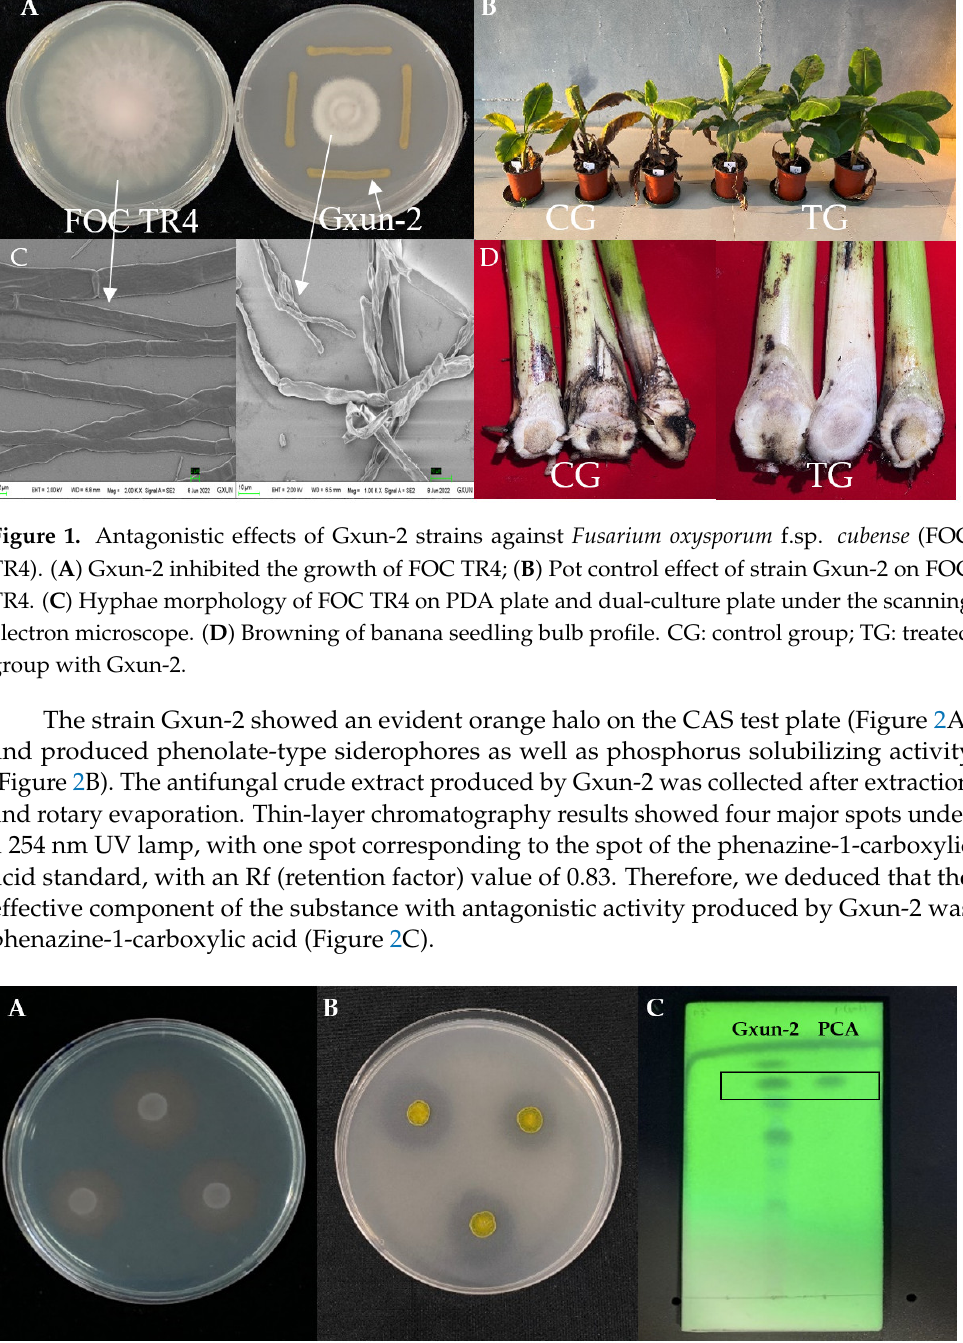
Figure 2. Plant growth-promoting and disease-prevention traits of the strain Gxun-2. ( A ) CAS test plate; ( B ) phosphate-solubilizing plate; ( C ) thin-layer chromatography. PCA: phenazine-1-carboxylic acid.